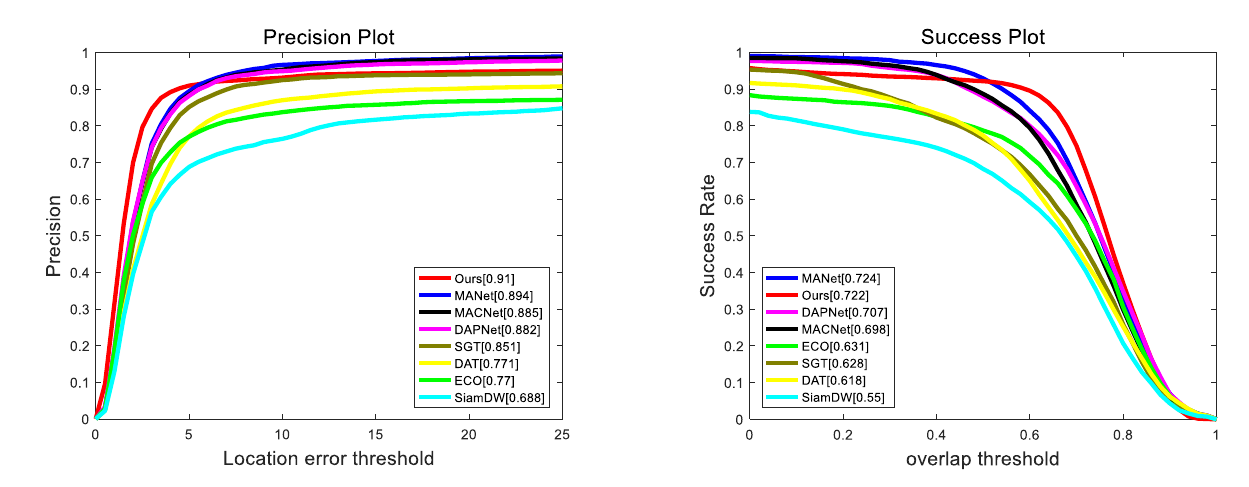
Figure 5. Precision rate (PR) and success rate (SR) curves of different tracking results on GTOT, where the representative PR and SR scores are presented in the legend. Table 1. Attribute-based accuracy and success rate (PR/SR) is obtained by using different trackers on the GTOT dataset. Red, green, and blue numbers represent the best one, the second-best one, and the third-best one,